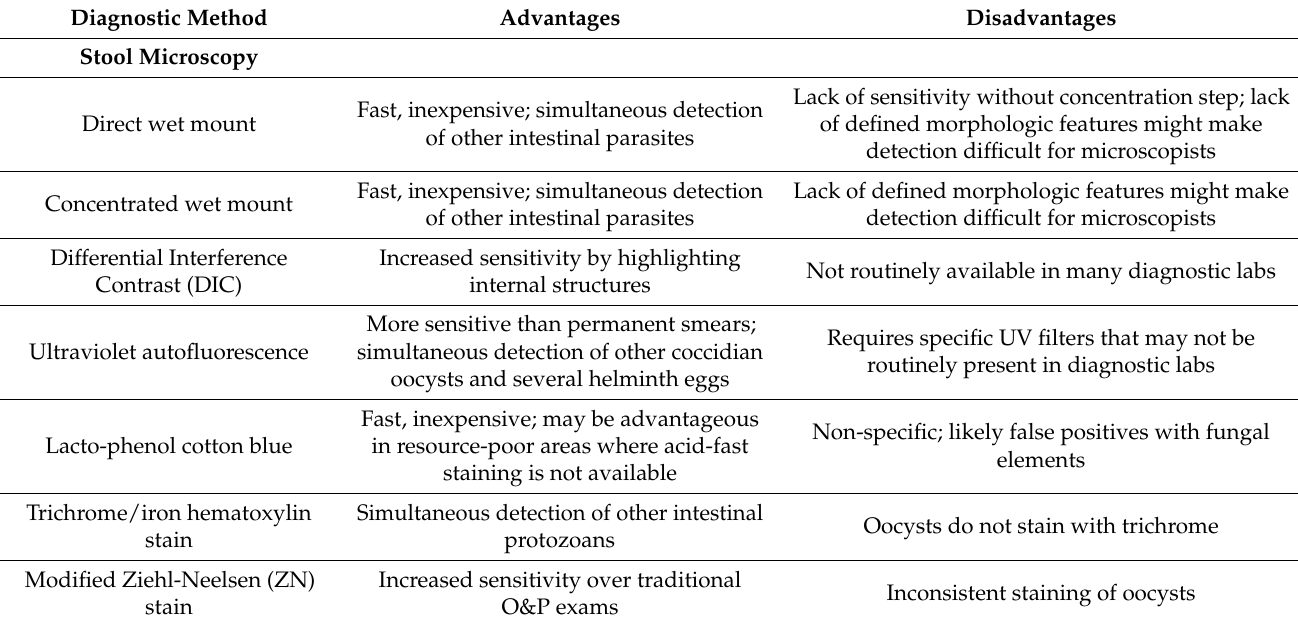
Table 1. Microscopic methods for the detection of Cyclospora cayetanensis